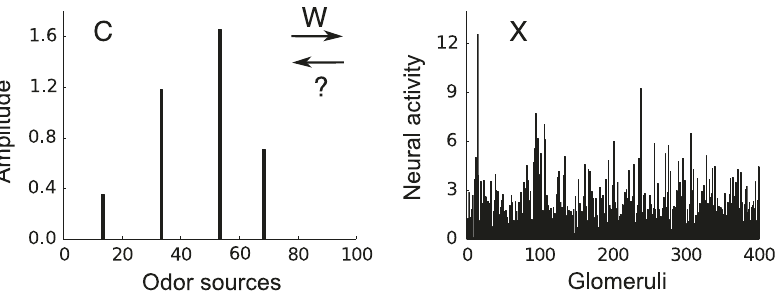
Fig. 1 Problem setting. An example odor stimulus, c (left), and the response at the glomeruli, x (right). The mixing weights (i.e., af fi nities), w (which are unknown to the animal) map odors, with concentration c , to OSN activity accumulated at the glomeruli, x . A goal of the animal is to infer the odor concentrations from the glomeruli activity.